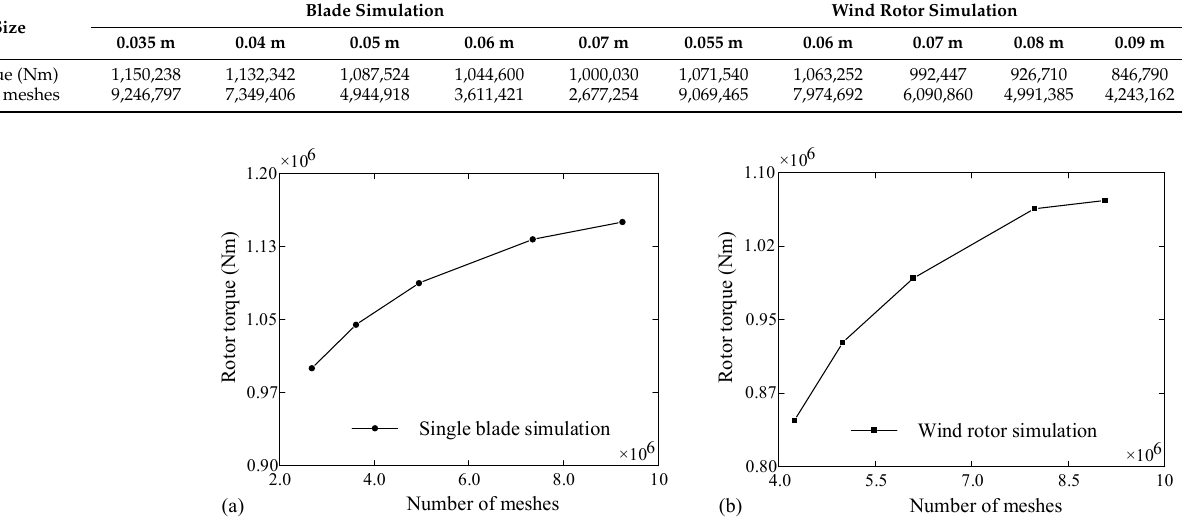
(b) Figure 12. CFD model verification results. ( a ) Power curve; ( b ) Thrust curve.